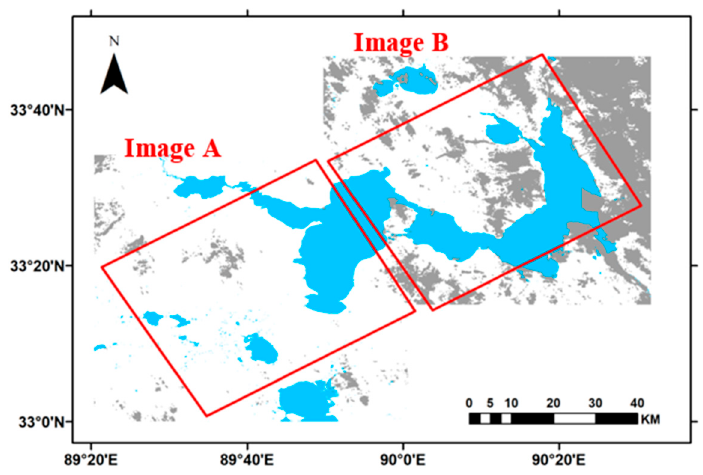
Figure 5. Lake water detected using Landsat OLI image acquired on 9 September 2016 (blue: water; grey: cloud; white: land or no retrievals). Table 3. Error matrix for the classification results of Image A.